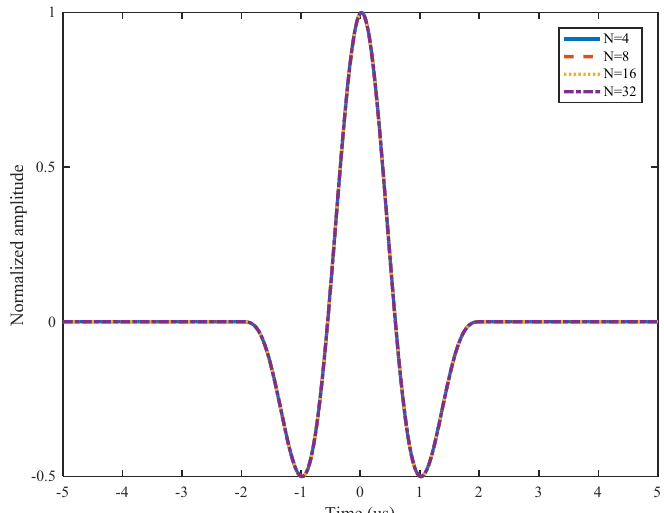
Figure 4. Autocorrelation curves of GCC signals with different numbers of cycles.